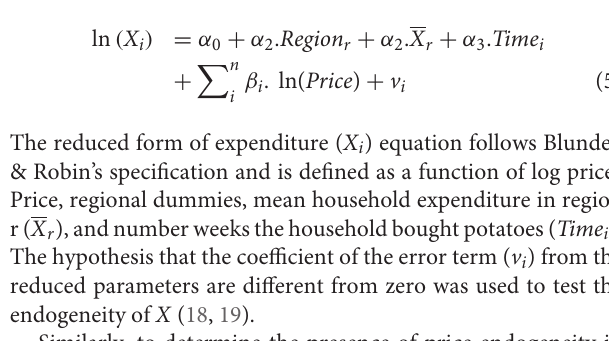
Frozen chips and other potatoes in the analysis. The